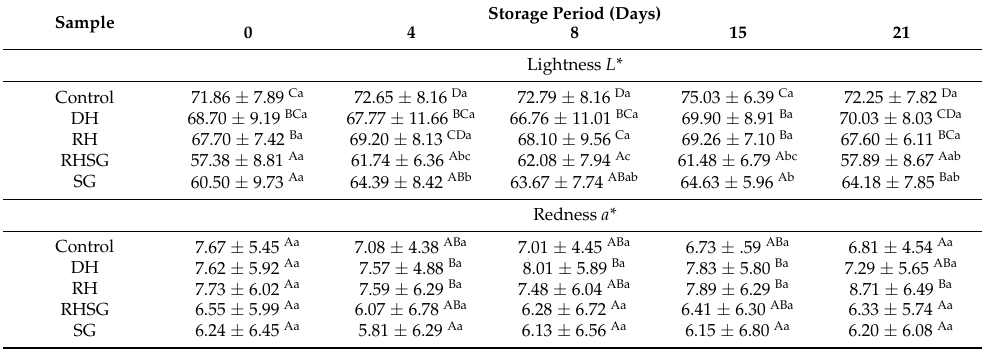
Table 5. The changes in the colour parameters of pork patties during the storage period (days). Values are least square means ± standard